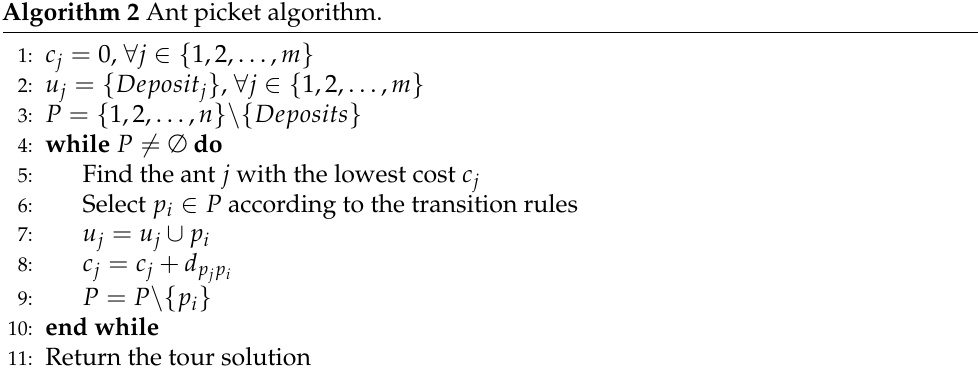
Algorithm 2 Ant picket